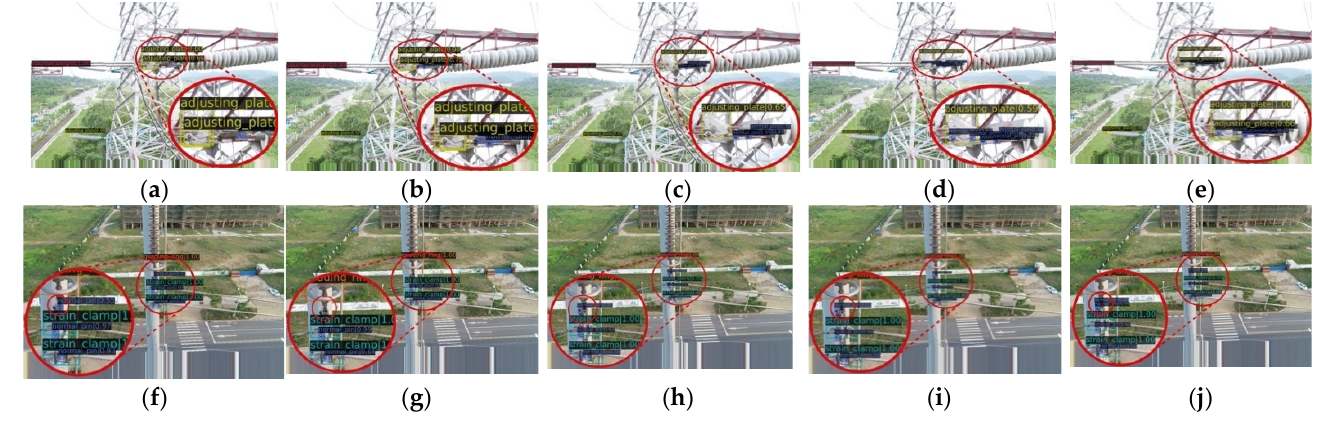
Figure 9. Visual results of the detected objects with different image sizes. ( a ) Size with 1333 × 800, ( b ) size with 1666 × 1000, ( c ) size with 1999 × 1200, ( d ) size with 2166 × 1300, ( e ) size with 2332 × 1400, ( f ) size with 1333 × 800, ( g ) size with 1666 × 1000, ( h ) size with 1999 × 1200, ( i ) size with 2166 × 1300, ( j ) size with 2332 × 1400.